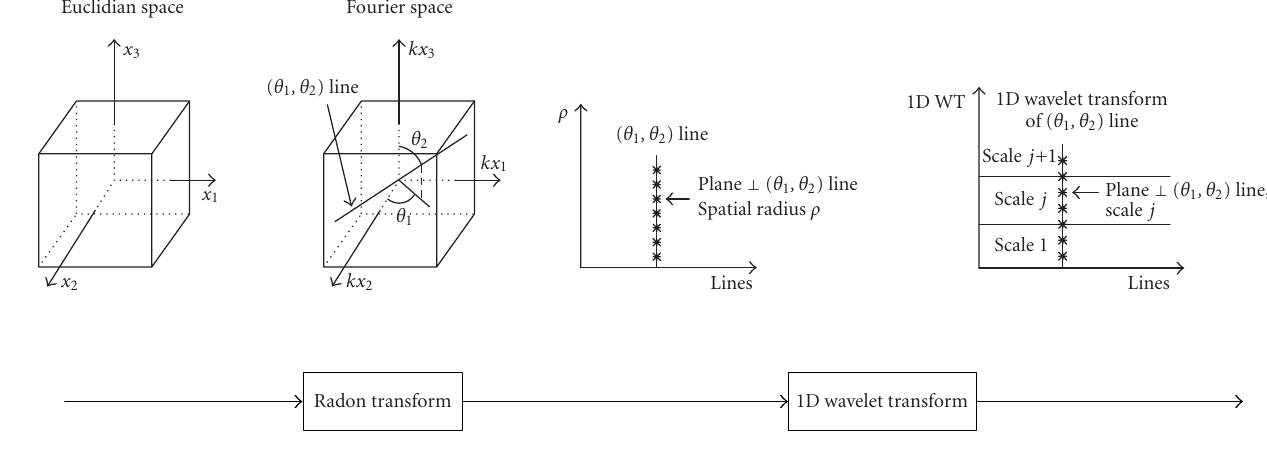
Figure 5: 3D ridgelet transform